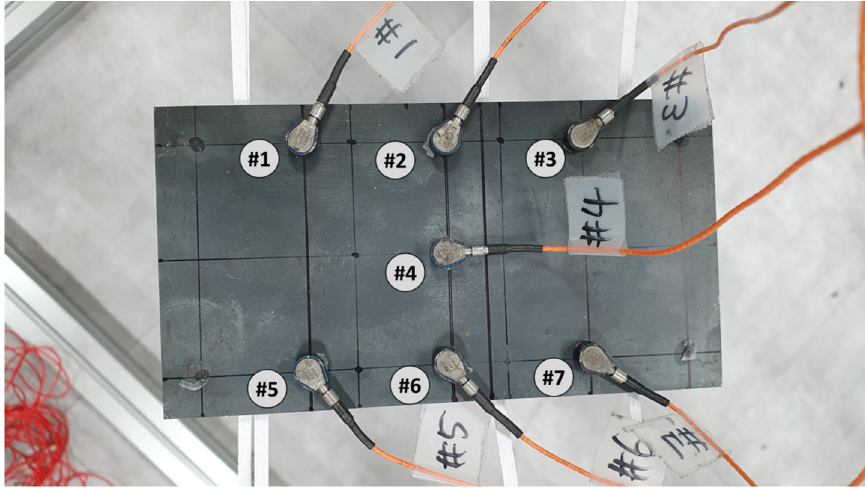
Figure 4. Configuration of the 12 layers of UD pre-implemented composite fibers, USN 250A [27].